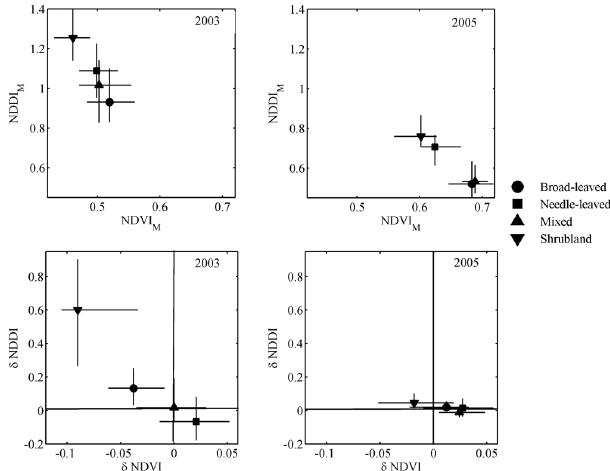
Fig. 6. Dispersion diagrams of centroids corresponding to the pairs { NDVI M , NDDI M } (top panel) and { δ NDVI, δ NDDI } (bottom panel), for all burnt pixels in the vicinity of burnt scars from 2003 (left panel) and the burnt scars from 2005 (right panel) fire seasons, for each of the main land-cover classes, according to the legend. Coordinates of the centroids are identified by filled circles in the dispersion diagrams, whereas horizontal and vertical bars indicate the interquartile